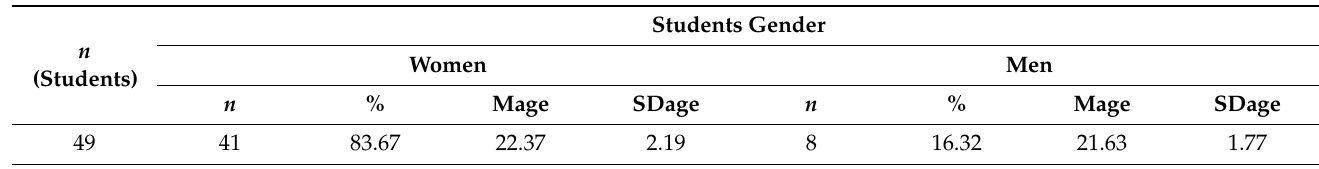
Table 1. Characteristics of the